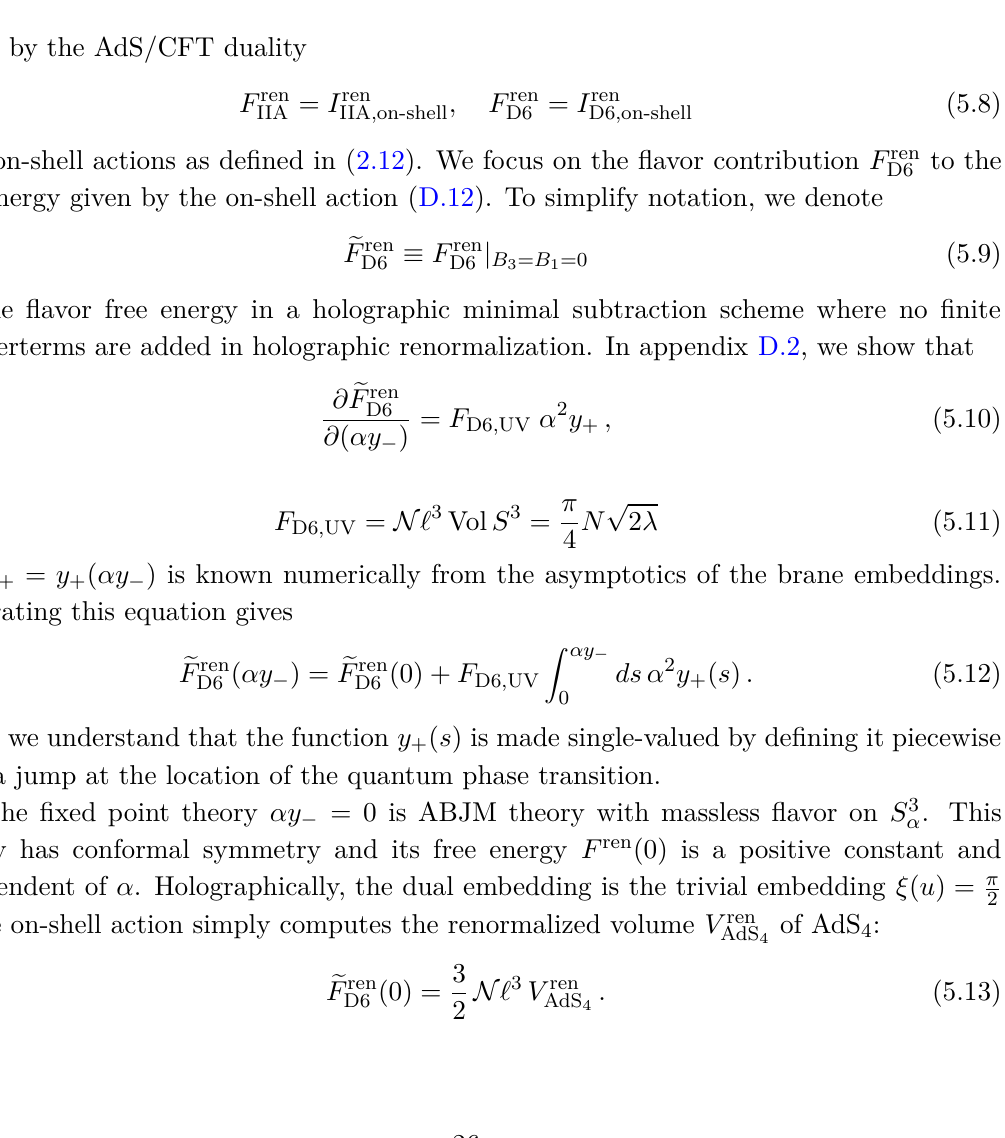
Figure 4. Renormalized on-shell action of the D6-brane (D.12) in the minimal subtraction scheme (5.9) as a function of the source in units with F D6,UV ≡ 1 . It diverges linearly as αy − → ∞